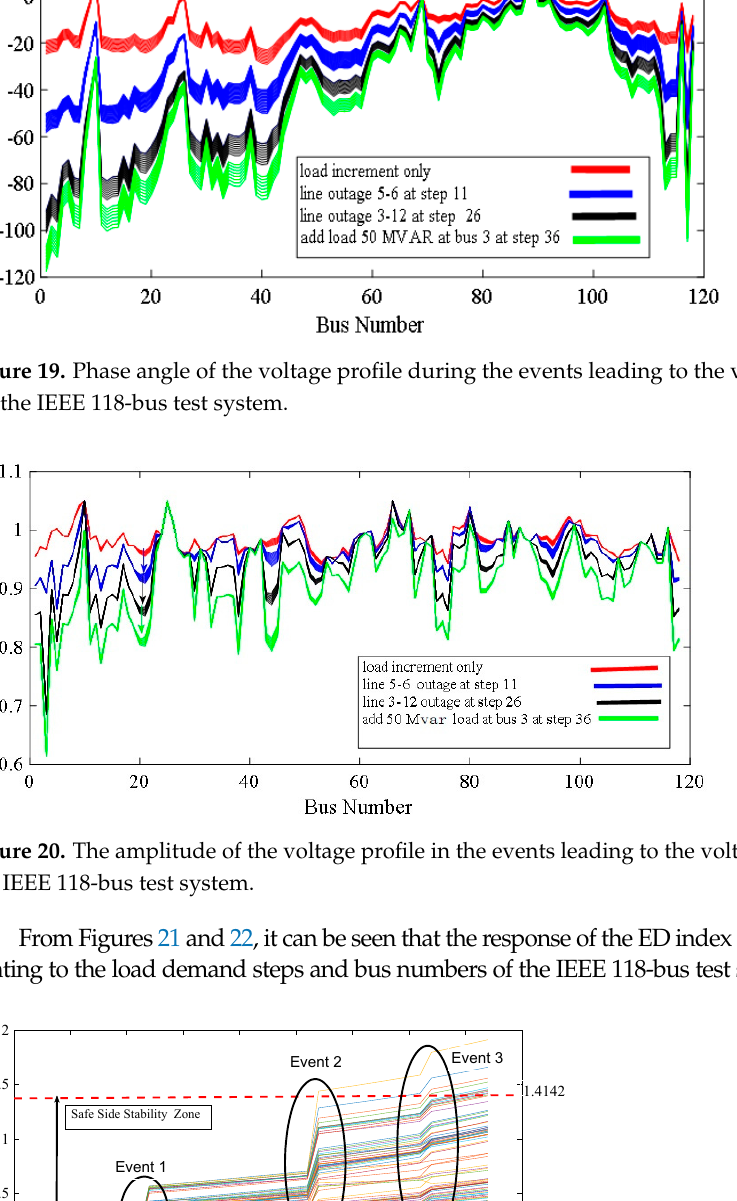
Figure 22. The response of the ED index for the case including three events related to the bus number for the IEEE 118-bus test system. 1.